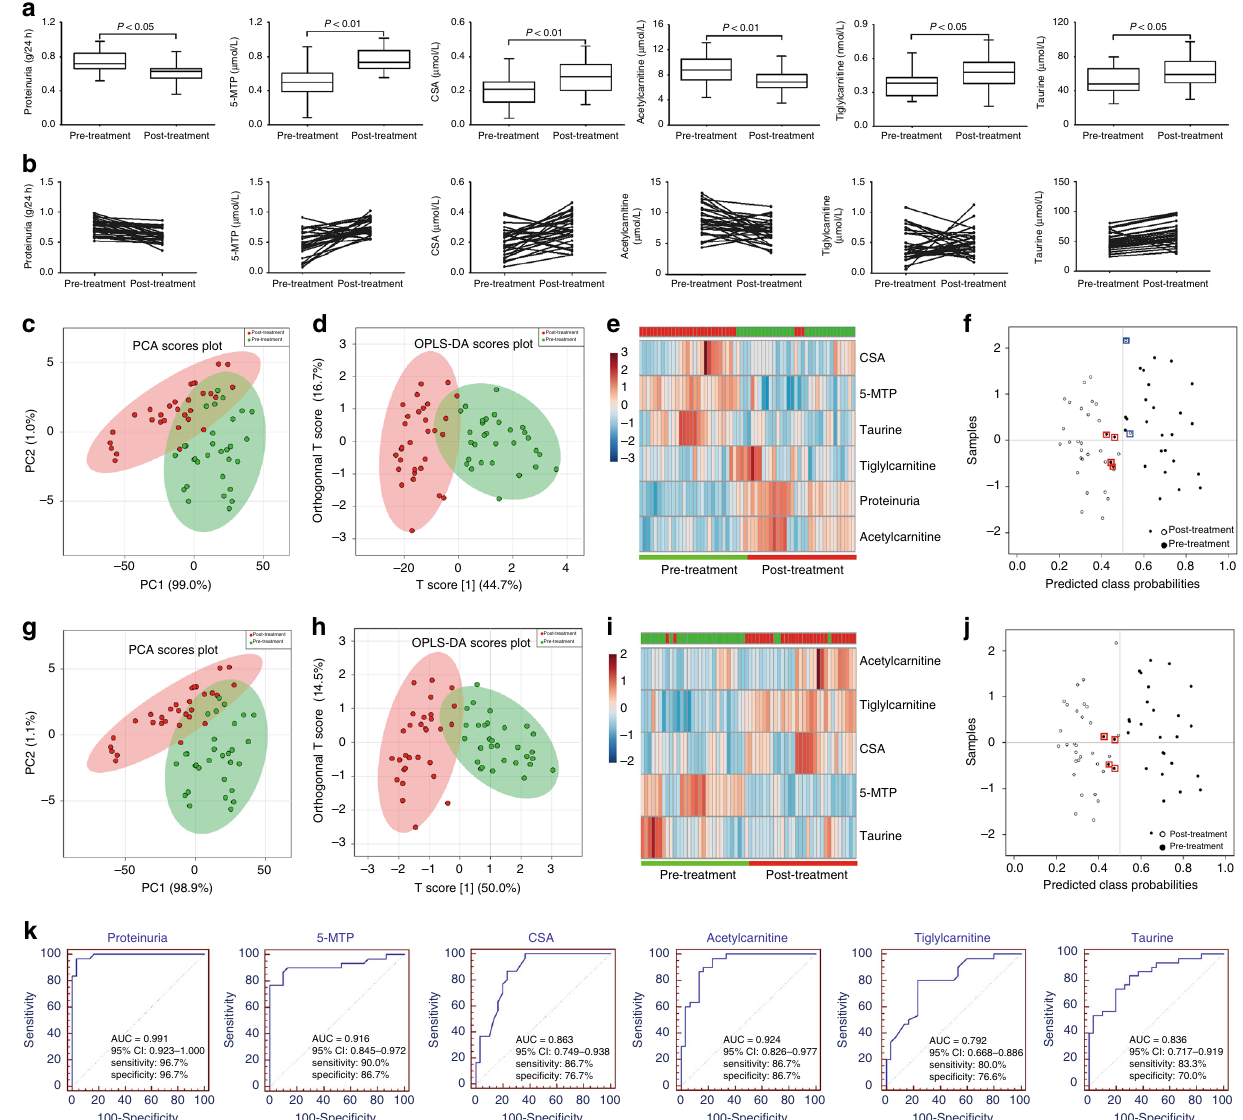
Fig. 5 Five potential biomarkers were further validated in pre- and post-treatment by Wulingsan. a Box plots of levels of fi ve potential biomarkers including 5-MTP, CSA, acetylcarnitine, tiglylcarnitine and taurine in patients with CKD2 pre- and post-treatment by Wulingsan. Mean values are presented by horizontal bars. The whiskers indicate the maximum and minimum points. b Dots and lines showing changes of fi ve potential biomarkers. c PCA of two components of proteinuria and fi ve biomarkers. d OPLS-DA of two components of proteinuria and fi ve biomarkers. e Heatmap of two components of proteinuria and fi ve biomarkers. f Diagnostic performances of two components of proteinuria and fi ve biomarkers based on the PLS-DA model. The black dots with red squares or black circles with blue squares are for the incorrectly predicted samples in pre- and post-treatment. 26 Out of the 30 patients with CKD2 of pre-treatment were located in pre-treatment area (86.6% speci fi city) and 28 out of the 30 patients with CKD2 of post-treatment were correctly grouped (93.3% sensitivity). g PCA of two components of fi ve biomarkers. h OPLS-DA of fi ve biomarkers. i Heatmap of fi ve biomarkers. j Diagnostic performances of fi ve biomarkers based on the PLS-DA model. The black dots with red squares and or black circles with blue squares are for the incorrectly predicted samples in pre- and post-treatment. 26 Out of the 30 patients with CKD2 of pre-treatment were located in pre-treatment area (86.6% speci fi city) and all the 30 patients with CKD2 of post-treatment were correctly grouped (100.0% sensitivity). These results demonstrated that the fi ve biomarkers show high prediction class probabilities. k Analysis of PLS-DA based ROC curves of proteinuria and fi ve potential biomarkers. The associated AUC, 95% con fi dence interval (CI), sensitivity and speci fi city values were indicated. Student ’ s t test was used for the signi fi cance of difference between two